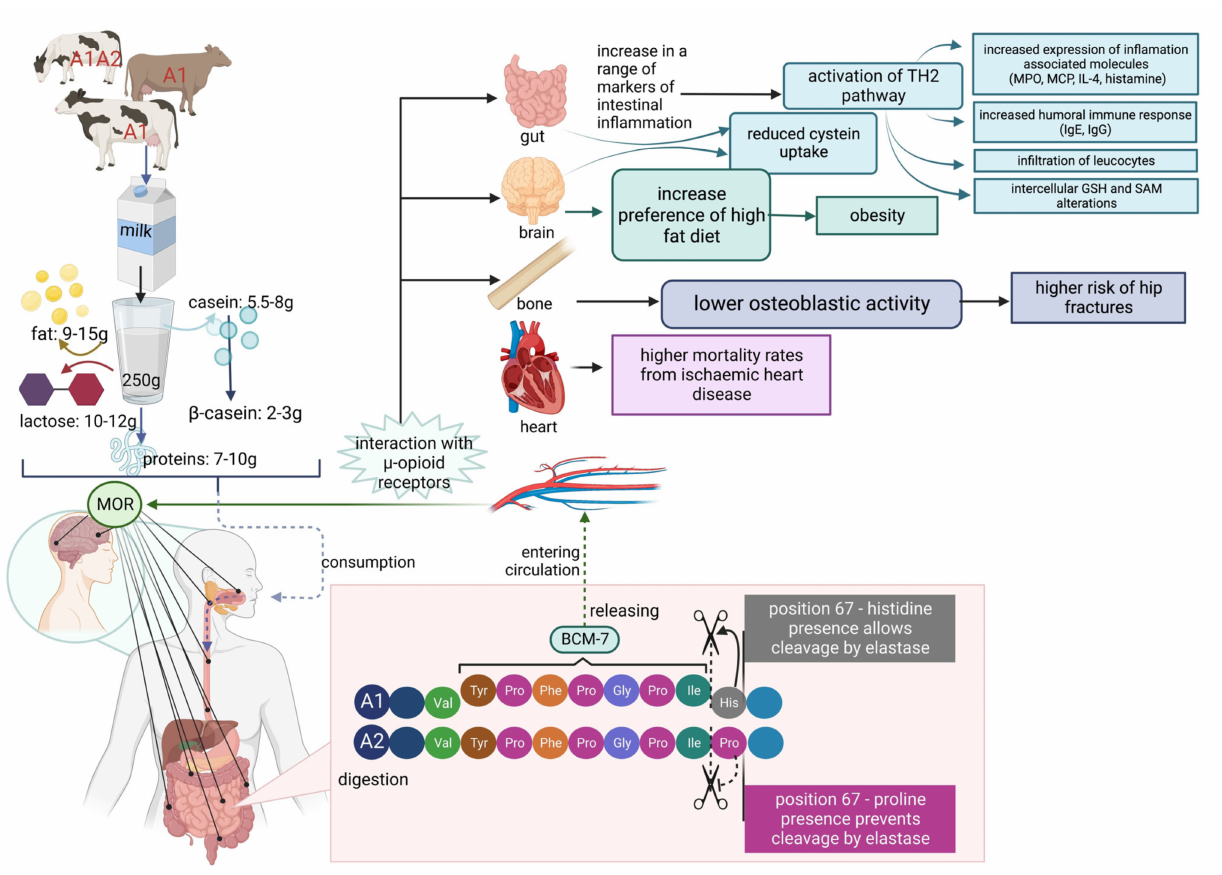
Figure 4. β -Casomorphin-7 influence on human body